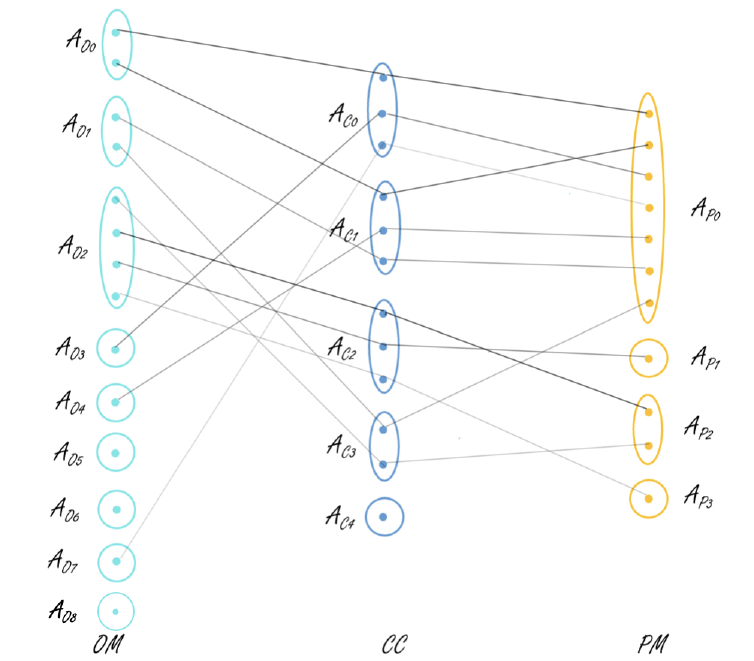
Figure 4. Tripartite graph representing the relationships between different concepts after receiving chunk 2. Color thickness of the edges correlates to the size of the